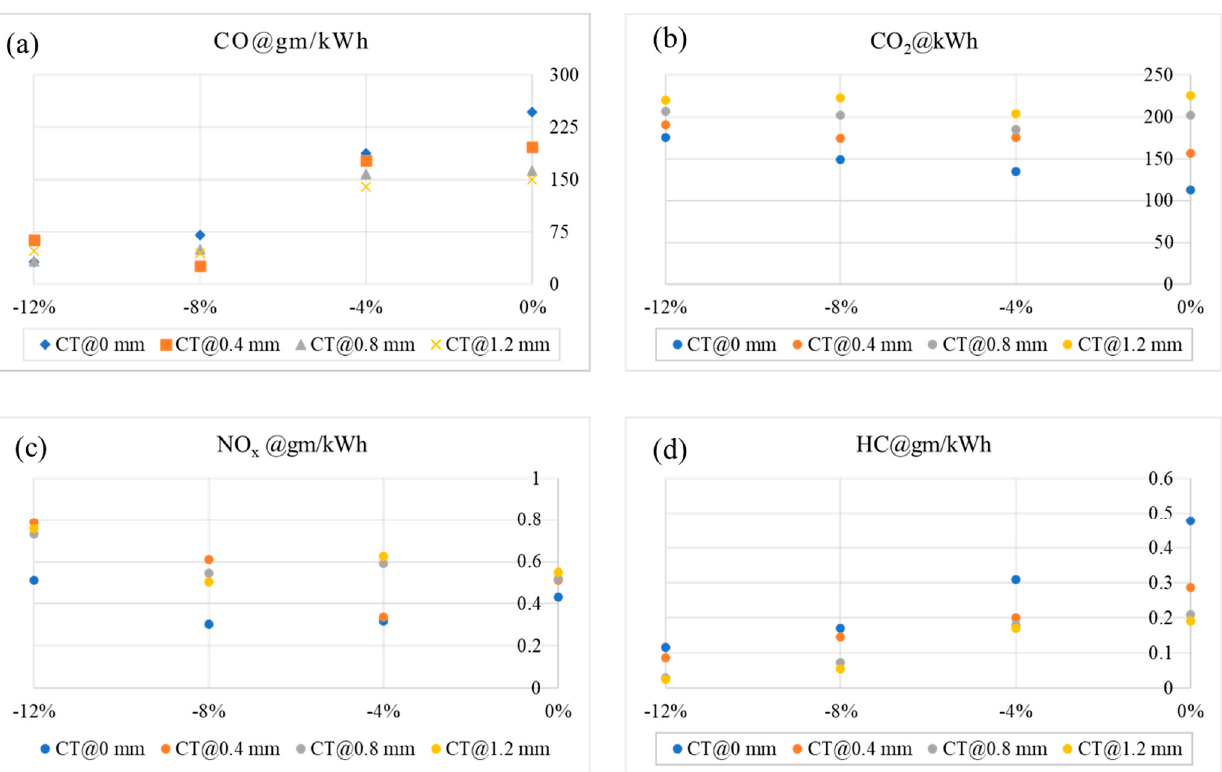
Figure 5. Fuel carbon redundancy effect on emission formation at 1500 rpm, BMEP@5.95 bar, and variable coating thicknesses: ( a ) CO@gm/kWh; ( b ) CO 2 @gm/kWh; ( c ) NO x @gm/kWh; ( d ) HC@gm/kWh.